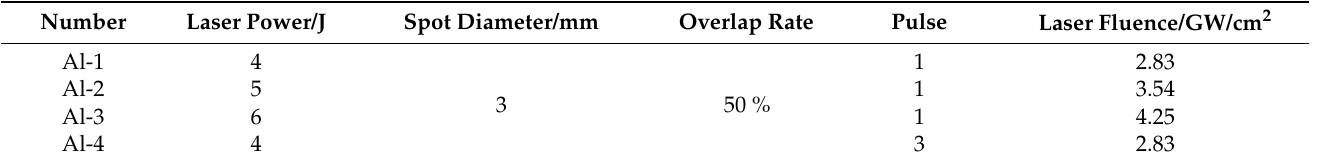
Table 2. Laser shock peening process parameters of the 7B04 aluminum alloy.